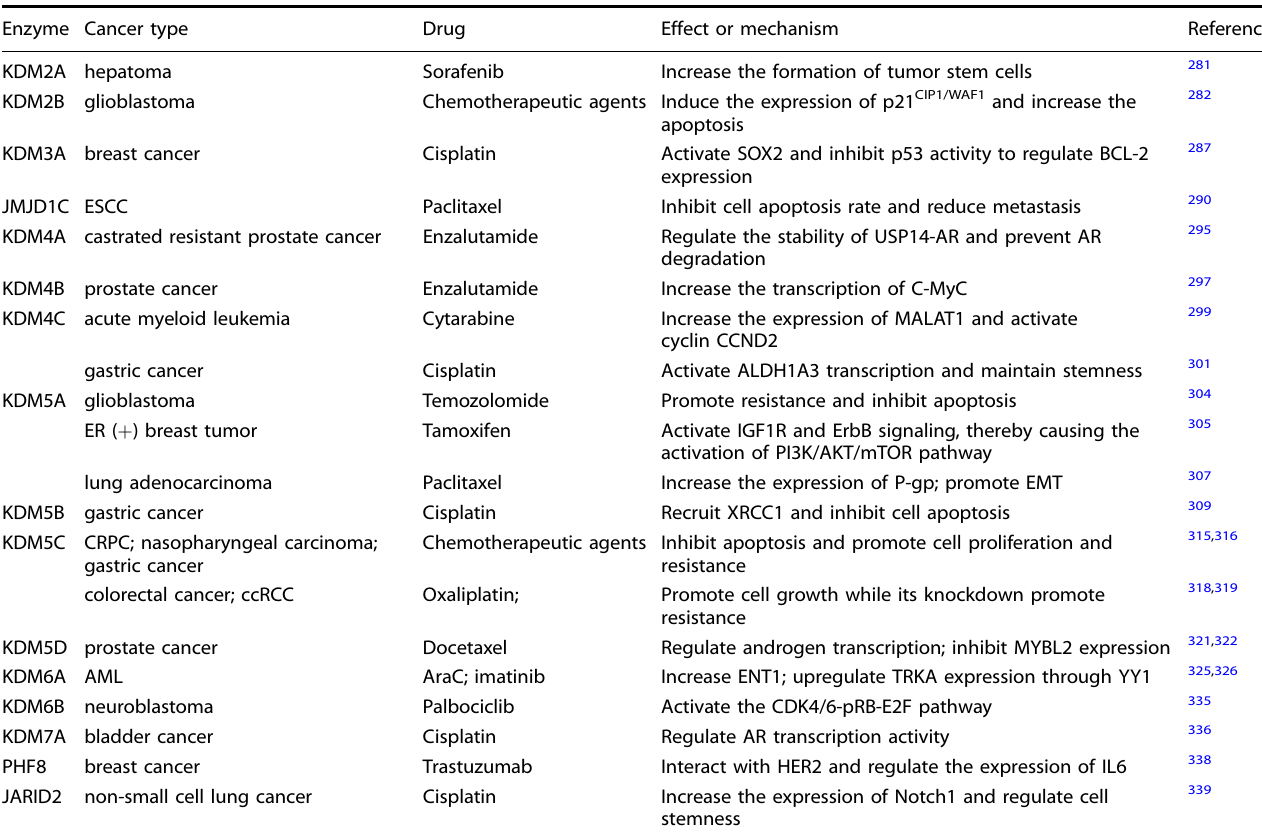
Table 3. Effects of proteins containing jumonji domain on drug resistance Enzyme Cancer type